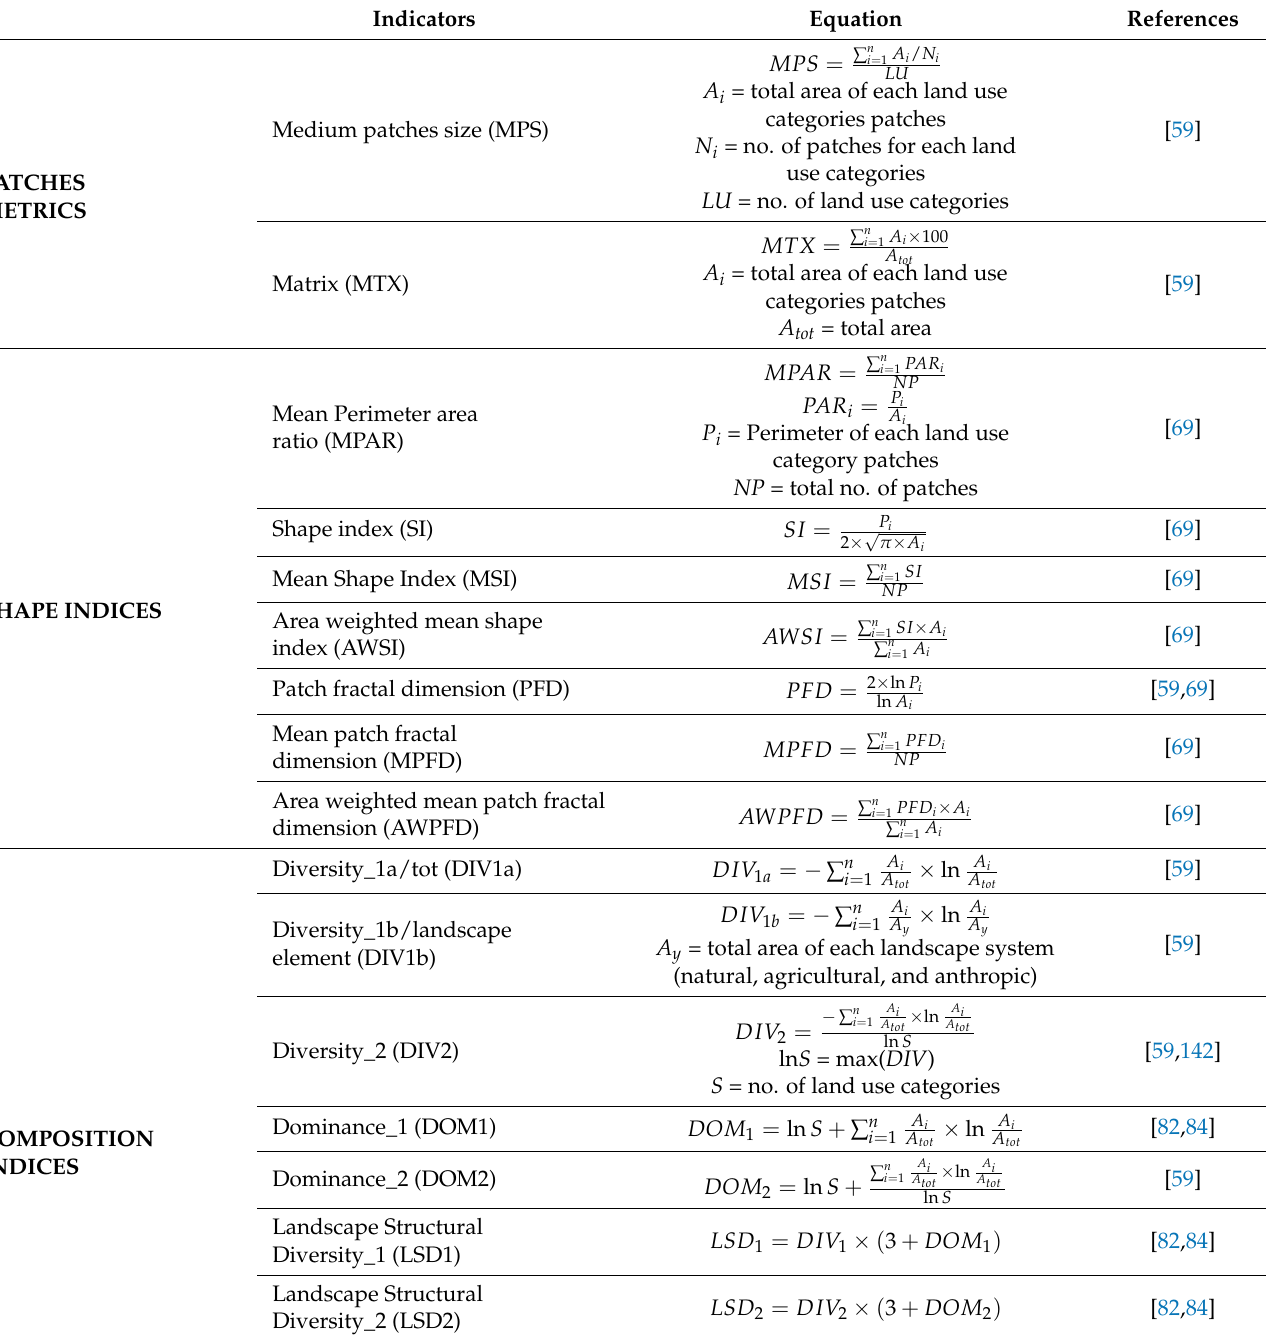
Table A1. Set of indicators under